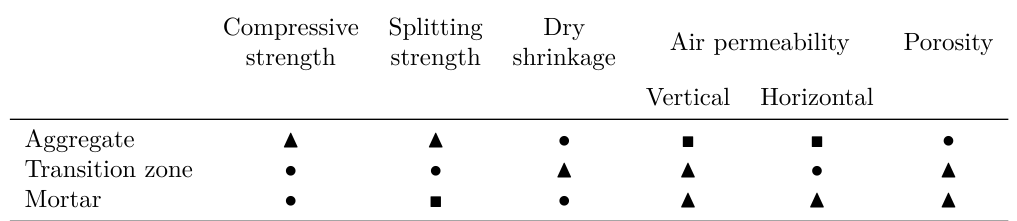
Table 3. List of contributions by